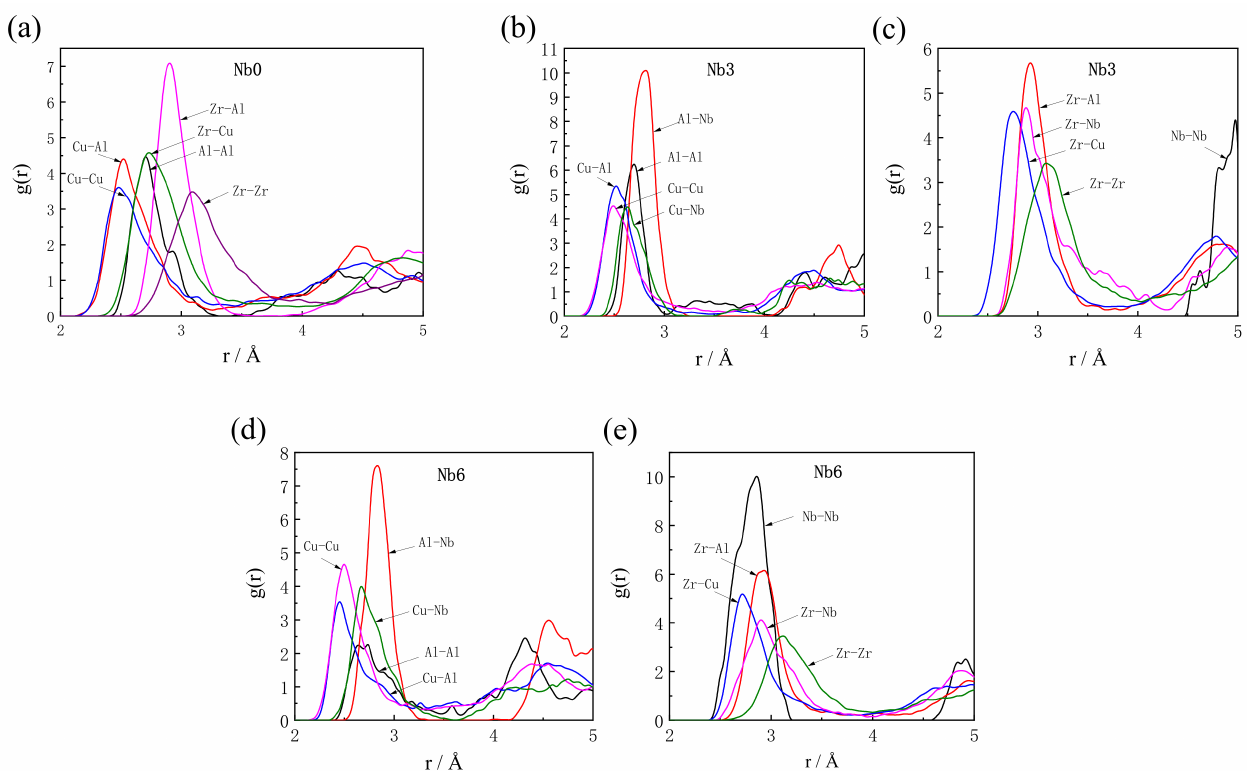
Figure 3. Partial binary correlation function of alloy simulated by AIMD at 300 K: ( a ) Nb0; ( b ) Nb3, ( c ) Nb3 and ( d ) Nb6, ( e )